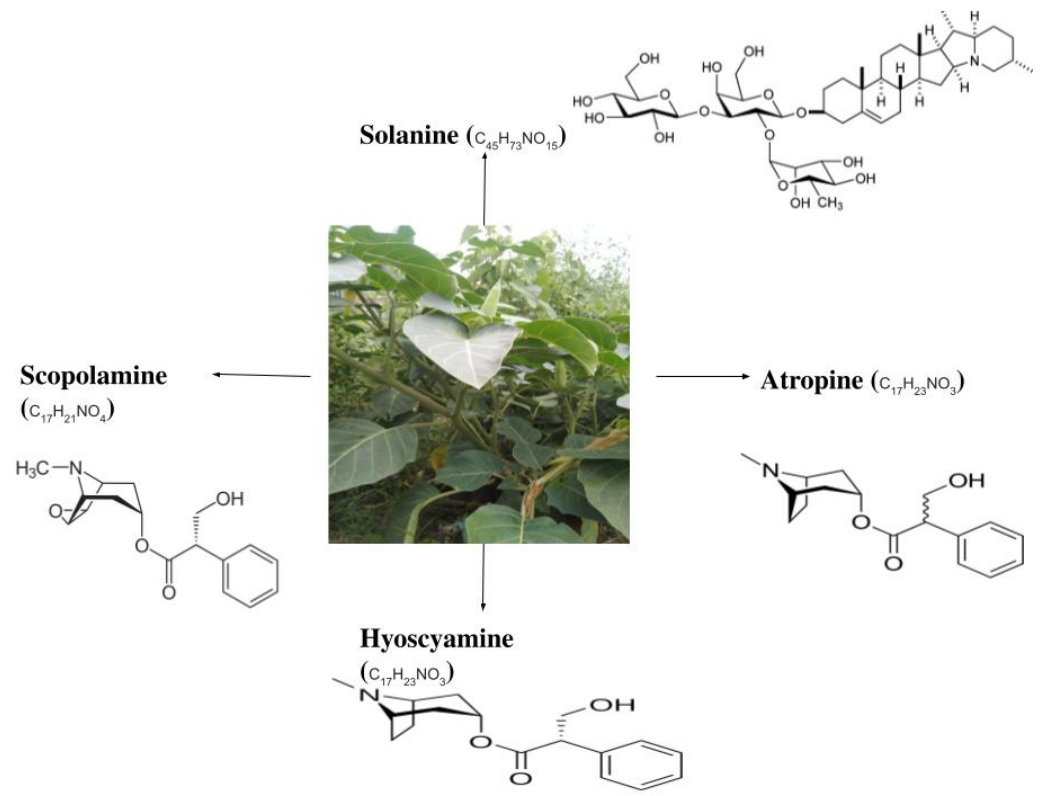
Figure 1. Identified important phytochemicals in Datura , as well as their chemical structures [30].